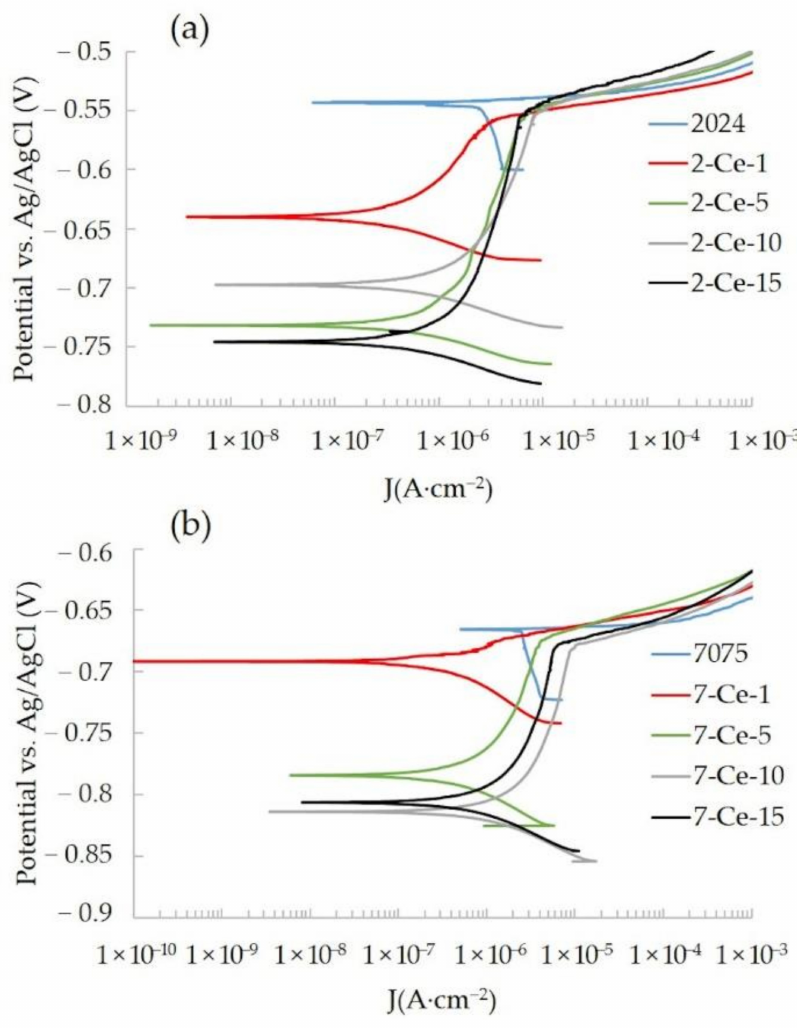
Figure 5. Potentiodynamic linear polarization (LP) curves in 3.5% NaCl. ( a ) 2024, ( b )